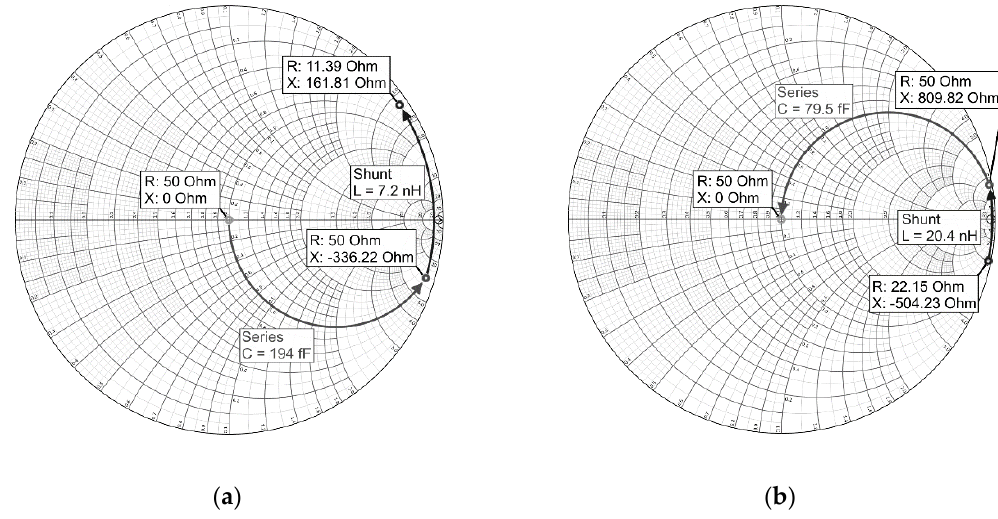
Figure 15. Smith’s chart plot for: ( a ) LNA input matching network; ( b ) LNA output matching network.